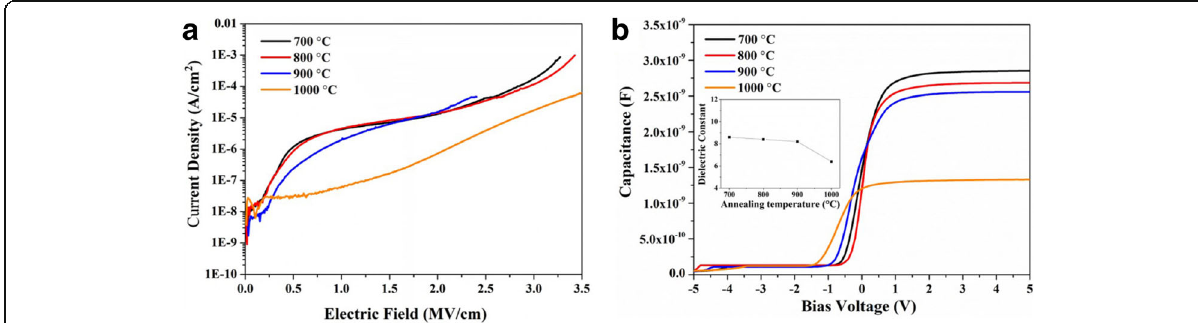
Fig. 5 a I-V behaviors and b the C-V behaviors of the composite films annealed at 700 – 1000 °C